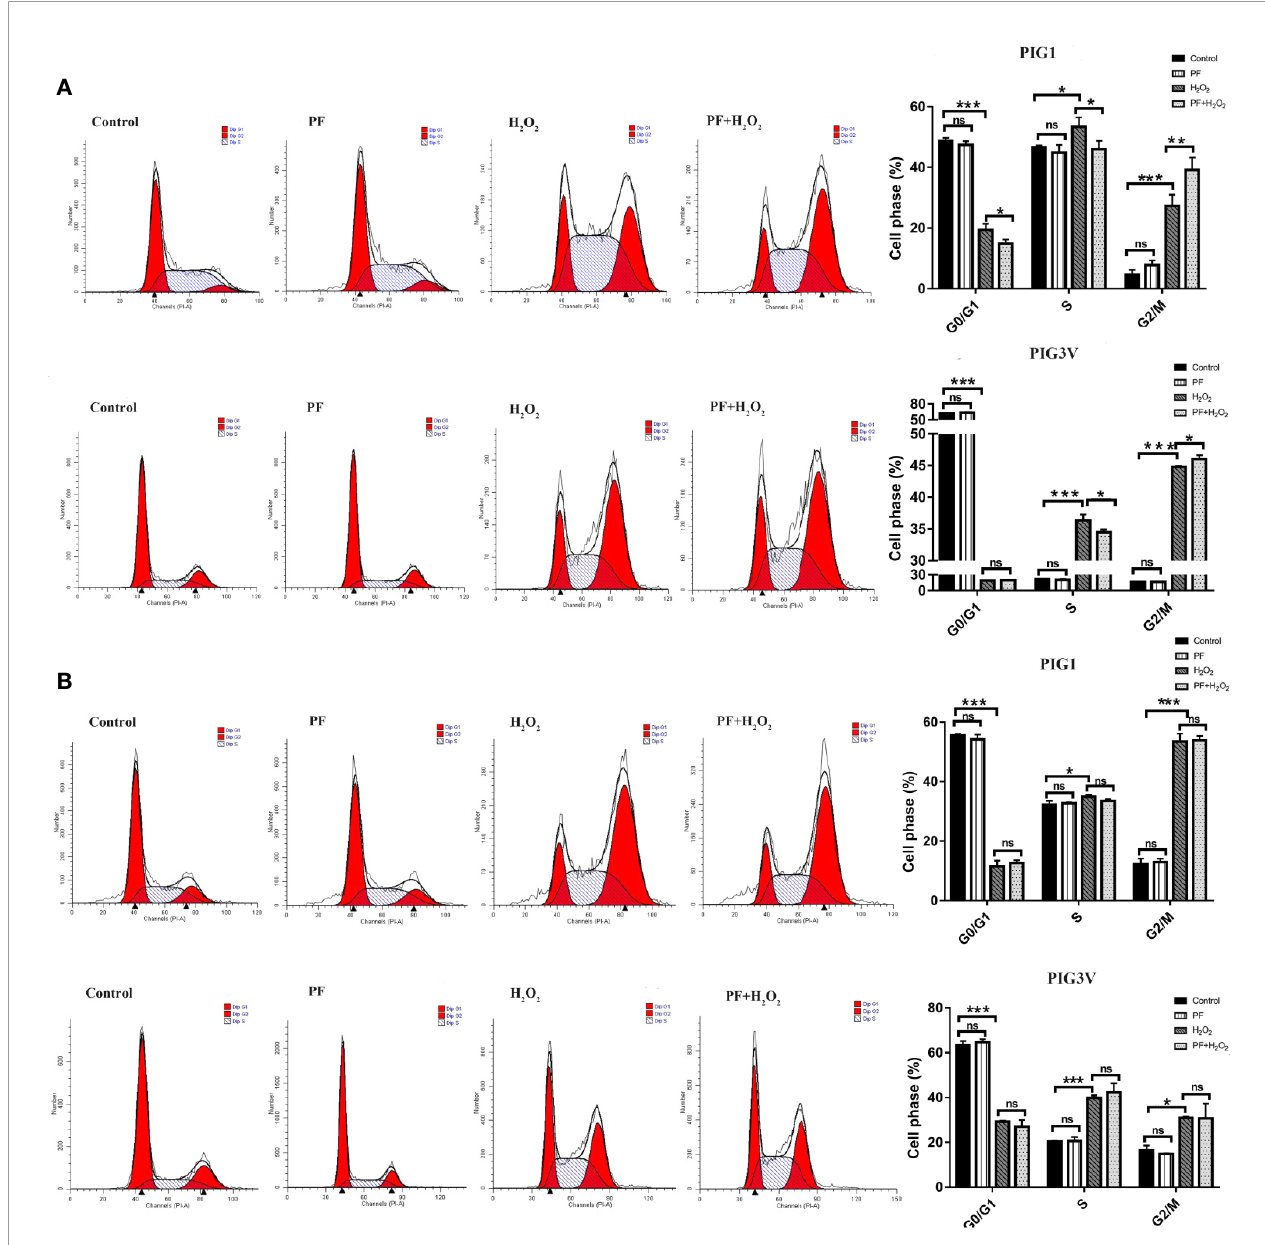
FIGURE 2 | PF regulates cell cycle progression in G2/M phase in stressed melanocytes. Melanocytes were pretreated with PF for 24 h (A) or 48h (B) and exposed to 1.0 mM H 2 O 2 for another 24 h. The cell cycles were analyzed by fl ow cytometry assay and the percentages of cells in each stage were shown as the right bar graphs. All data were presented as the mean ± standard deviation across three independent experiments. * P < 0.05, ** P < 0.01, *** P < 0.001. ns, not signi fi cant; H 2 O 2 , hydrogen peroxide; PF, Paeoni fl orin; h, hours; M,